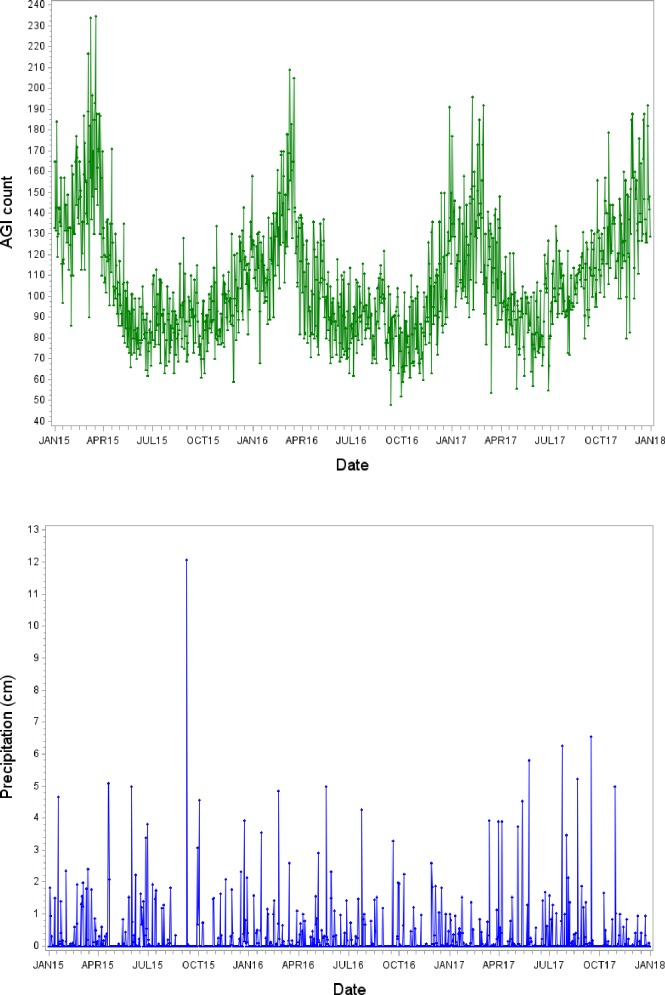
Timeseries plots of daily values during the study period, for: a) AGI counts identified by syndromic surveillance; b) total precipitation recorded at the Philadelphia International Airport.